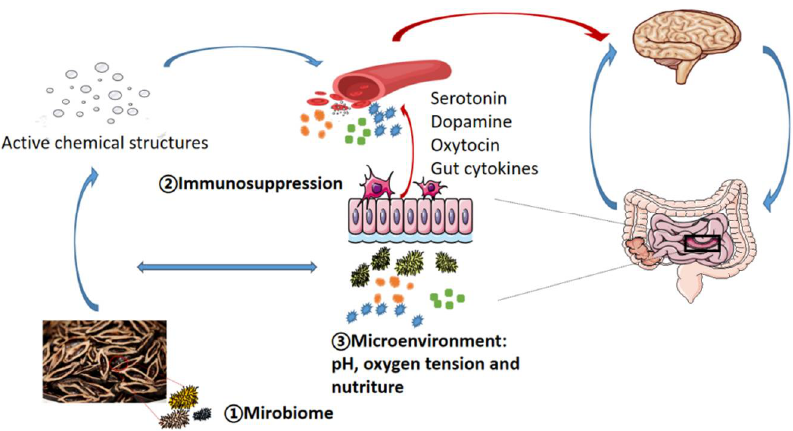
Figure 2. The possible mechanisms of AN-chewing-induced microbial dysbiosis and the role of gut microbiota in areca nut metabolism, as well as the direct and indirect interaction among gut microbiota, neuroendocrinology, and addiction.